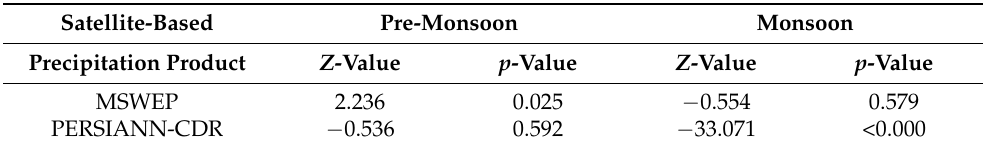
Figure 4. ( a ) MSWEP pre-monsoon precipitation trend; ( b ) MSWEP monsoon precipitation trend; ( c ) PERSIANN-CDR pre-monsoon precipitation trend; ( d ) PERSIANN-CDR monsoon precipitation trend. The red dotted line indicates the linear regression. Table 2. p - and Z -value of pre-monsoon and monsoon precipitation trends using Modified Mann- Kendall for the GBM river basin during 1983–2019.